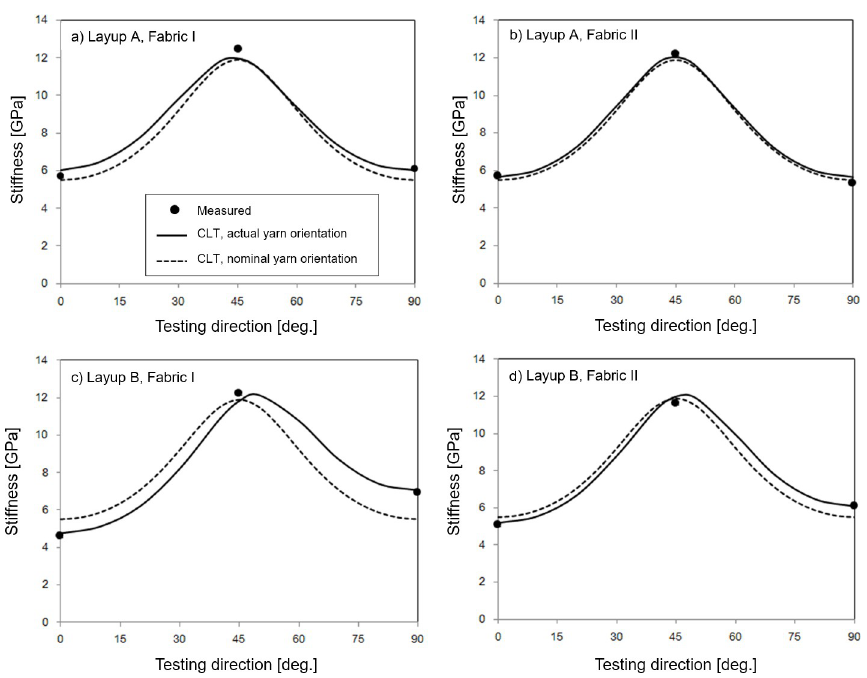
Fig 10. Relationship between stiffness and testing direction of the multiaxial flax fibre composite laminates with layup A: (a) fabric I and (b) fabric II, and with layup B: (c) fabric I and (d) fabric II. Data points are measured stiffness. Full lines are CLT predictions using the actual yarn orientation in the composites, as measured by the FFO method. Dotted lines are CLT predictions using a nominal yarn orientation on ± 45˚ in the